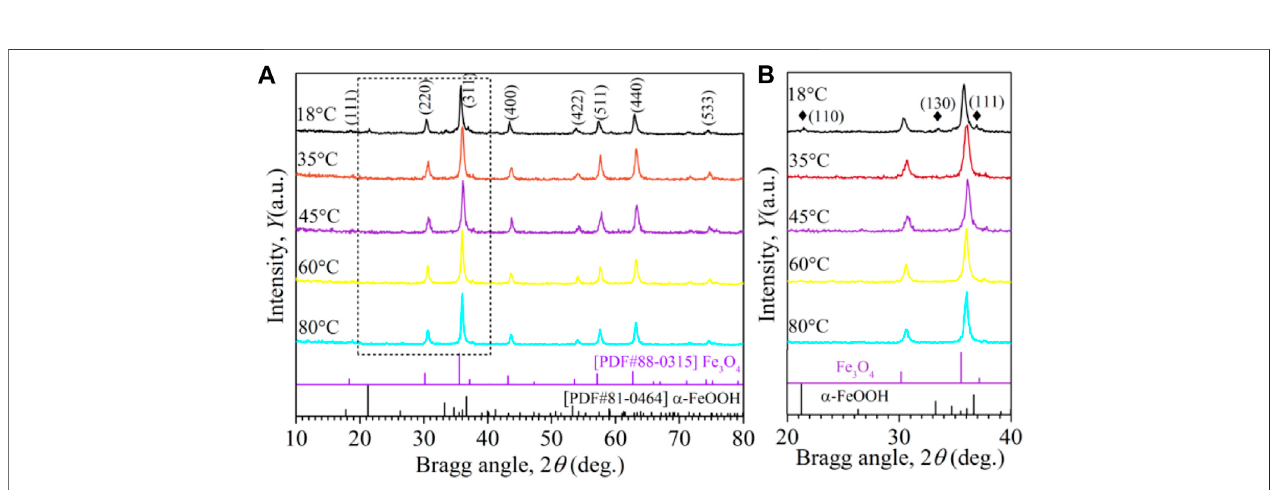
FIGURE 2 | (A) XRD pro fi les of the samples prepared at different reaction temperatures, (B) the extended XRD pro fi les from 20 to 40 ° .